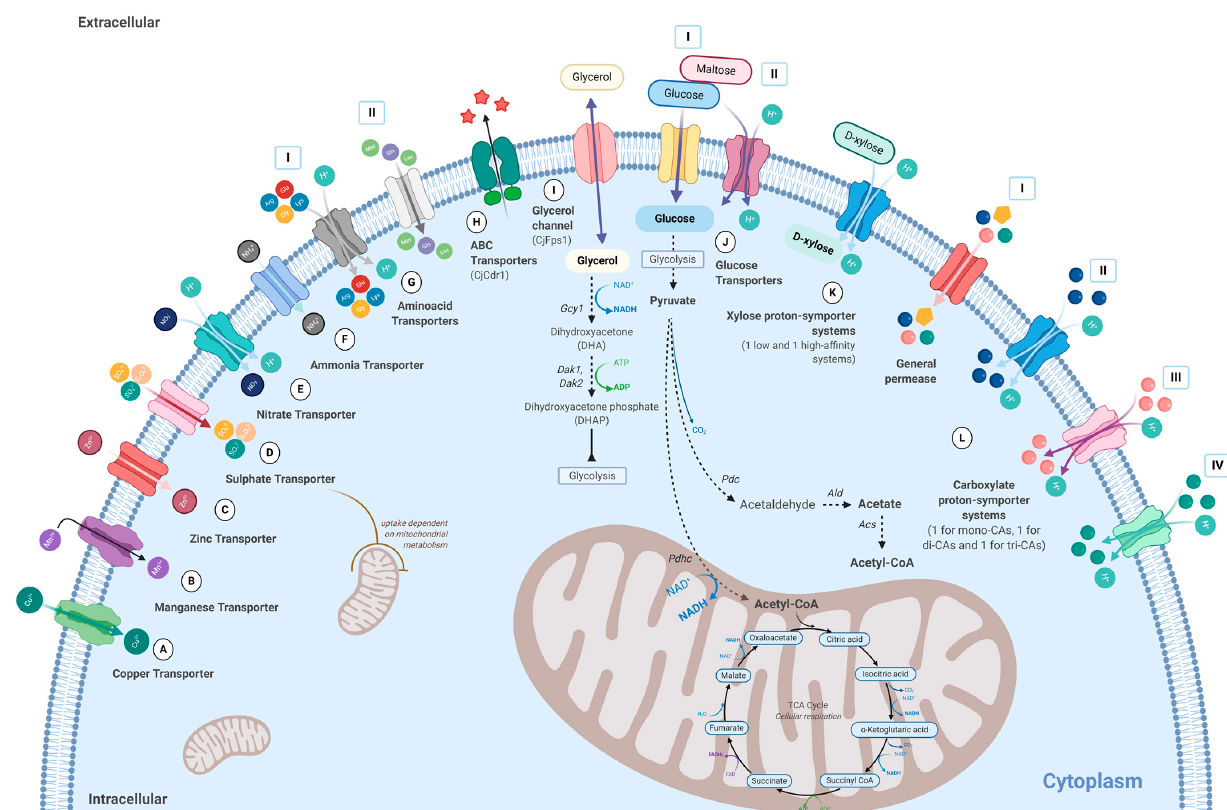
Figure 3. Plasma membrane transporters functionally characterized in Cyberlindnera jadinii (A–L). The main metabolic pathways of yeast general metabolism are also presented. Symbols represent the specificities uncovered for each of the protein-system: drugs—pink star, amino acids—yellow pentagon, monocarboxylic acids—blue filled circle, dicarboxylic acids—rose filled circle, and tricarboxylic acids—green filled circle. I-IV corresponds to different transporter systems with the same type of substrate G-I: amino acid proton symporter; G-II: facilitated diffusion of L-methionine, L-glutamine, and L-leucine; J-I glucose proton-symporter; J-II glucose facilitated diffusion; L-I facilitated diffusion of the undissociated form of carboxylic acids (general permease); L-II monocarboxylate proton symporter; L-III dicarboxylate-proton symporter; L-IV tricarboxylate-proton symporter. Initials stand for Mg 2+ , magnesium; Mn 2+ , manganese; SO 42 − , sulfate; SO 32 − , sulfite; S 2 O 32 − , thiosulfate; NH 4+ , ammonia; NO 3 − , nitrate; Cu 2+ , copper; Zn 2+ , zinc; H + , proton; Gln, L-glutamine; Met, L-methionine; Leu, L-leucine; Arg, arginine; Lys, lysine; Gly, glycine; Glu, glutamate; Gcy1 , glycerol dehydrogenase; Dak1, Dak2 dihydroxyacetone kinases; Pdhc, pyruvate dehydrogenase complex; Pdc, pyruvate decarboxylase; Ald , aldolase; Acs , acetyl-CoA synthetase; Acetyl-CoA , acetyl coenzyme A; TCA cycle, tricarboxylic acid cycle; NAD + , reduced form from nicotinamide adenine dinucleotide ; NADH, nicotinamide adenine dinucleotide ; FADH, flavin adenine dinucleotide ; FAD + , reduced form from flavin adenine dinucleotide ; ATP, adenosine triphosphate ; ADP , adenosine diphosphate ; CO 2 , carbon dioxide ; H 2 O, water.